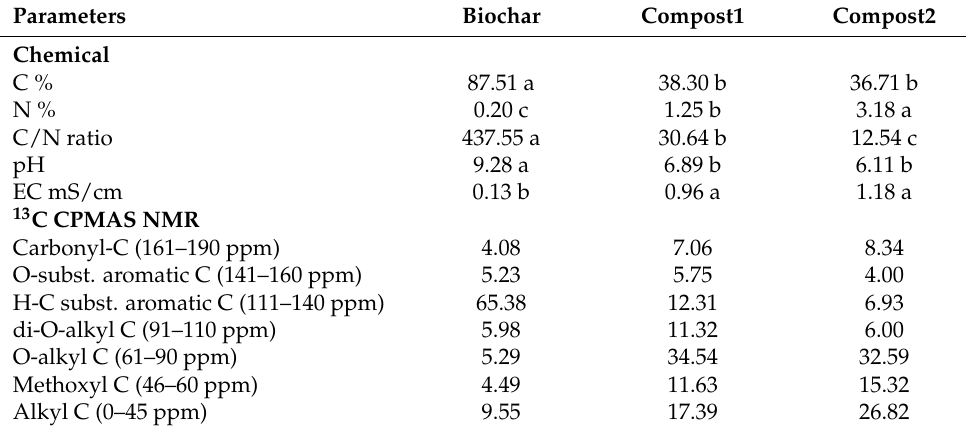
Table 1. Content of organic carbon, total nitrogen, pH, electric conductivity, C/N ratio and 13 C CPMAS NMR data of the wood biochar and the two-compost type. Different letters within each column indicate significant difference ( p < 0.05).